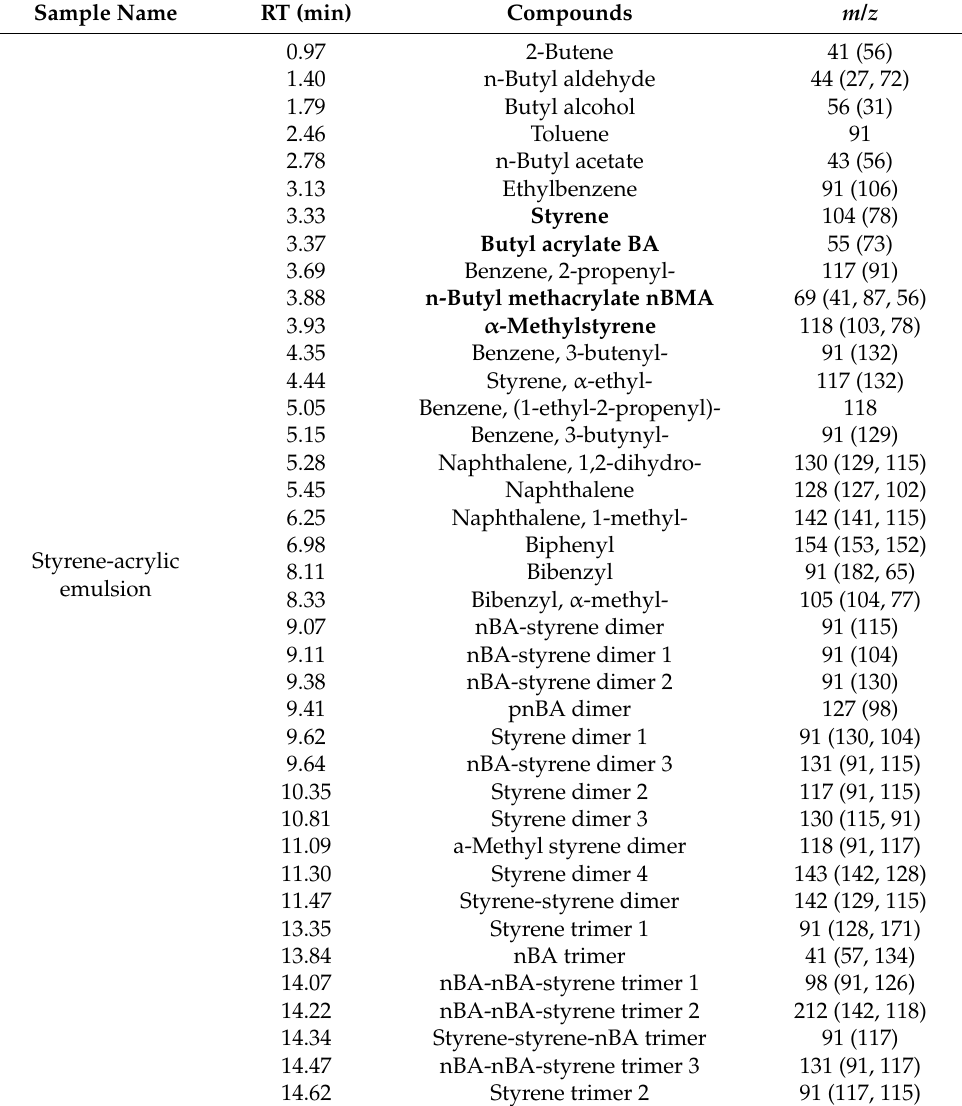
Table 2. Compounds identified in unaged pure styrene-acrylic emulsion by Py-GC/MS analysis. The most intense peaks were listed in